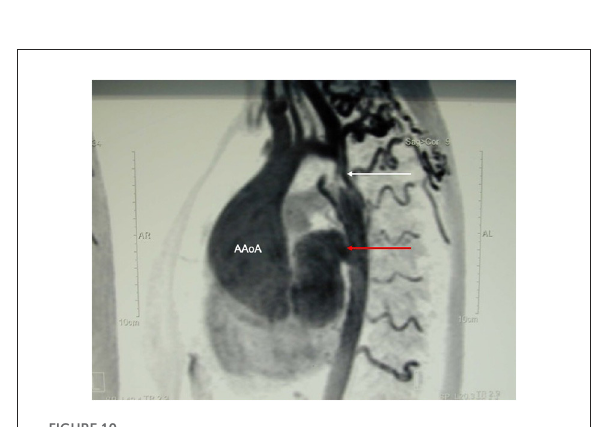
FIGURE10 MR-angiography showing a large aneurysm of the ascending aorta (AaoA), a hypoplastic aortic arch and a recurrent stenosis following previous coarctation repair (white arrow) and enlarged intercostal arteries as sign of collateralization. In addition, there was a large pseudoaneurysm at the site of a Dacron patch used for initial coarctation repair (red arrow).